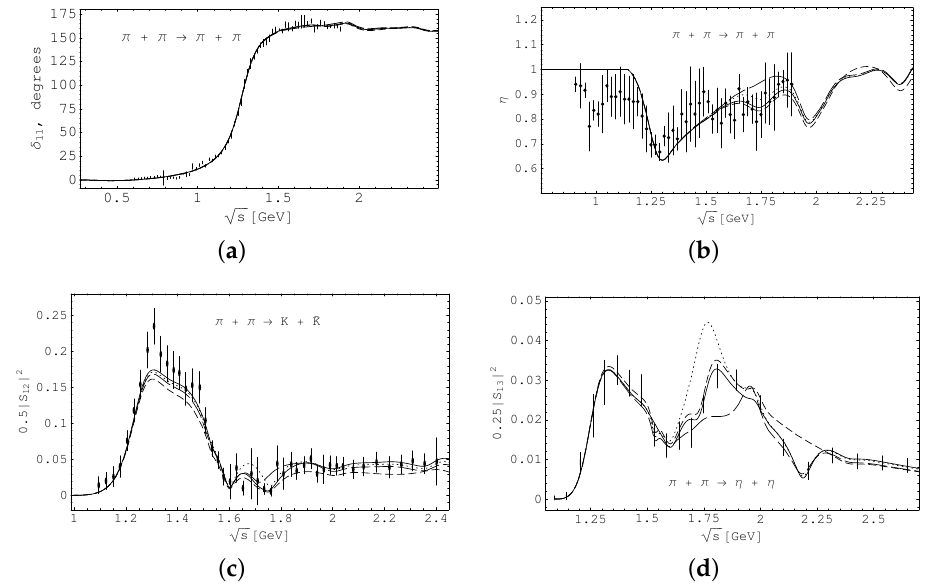
Figure 4. Scattering properties of the ππ → ππ , K ¯ K , ηη processes for four scenarios: (1) full result with inclusion of all relevant f 2 -resonances (solid lines); (2) f 2 ( 1719.8 ) state is excluded (dotted line); (3) f 2 ( 2202 ) state is excluded (short-dashed line); (4) f 2 ( 1760 ) state is excluded (long-dashed line). The experimental data are from Refs. [31,32]. ( a ): Phase shift and in the D -wave ππ -scattering. ( b ): Modulus of the S -matrix element in the D -wave ππ -scattering. ( c ): Squared moduli of the S -matrix element in the D -wave ππ → K ¯ K process. ( d ): Squared moduli of the S -matrix element in the D -wave ππ → ηη